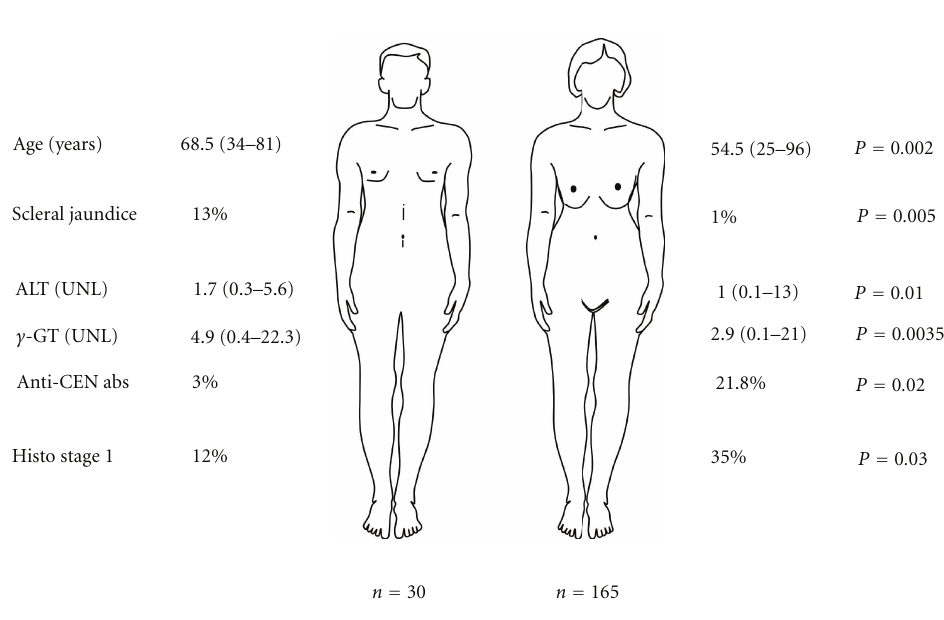
Figure 2: Clinical and Laboratory di ff erences between women and men with PBC. The figure illustrates the significant di ff erences between the Italian cohorts of men and women with PBC analysed by Muratori et al. [52] Only the parameters that reached statistically significant di ff erence are given. More details are provided within the text; UNL, upper normal level; histo, histological; CEN, centromere; abs,